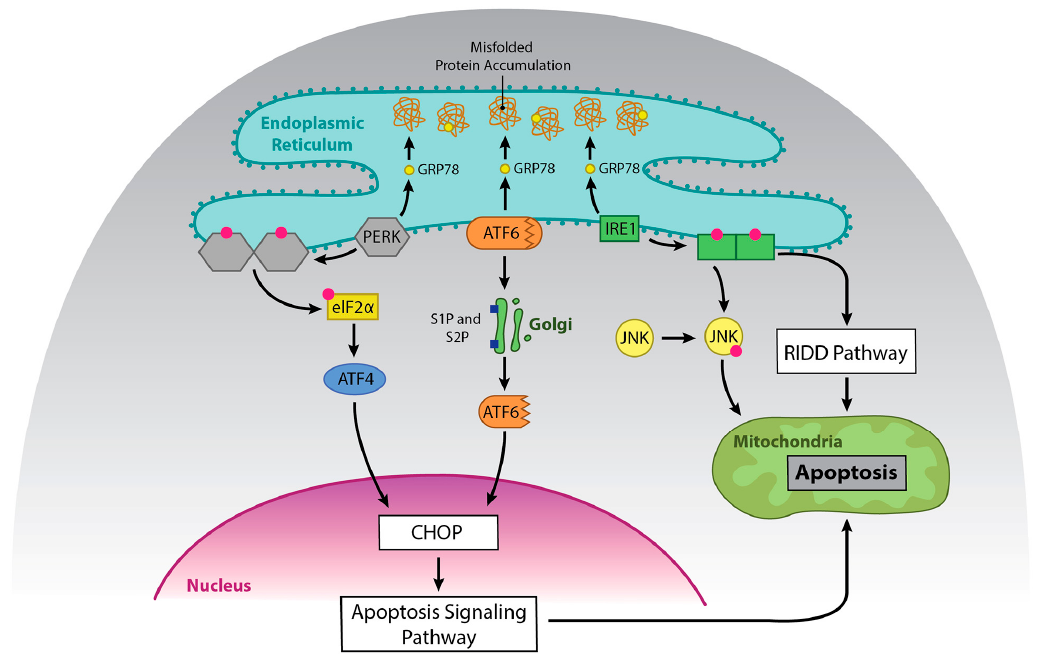
Figure 2. The role of UPR in cell death upon prolonged ER stress. Prolonged activation of UPR can promote apoptosis. Dimerization and phosphorylation of PERK promotes ATF4, which activates CHOP and subsequently apoptosis. ATF6 can also promote upregulation of CHOP. IRE1 α can promote apoptosis via activation of JNK and via degradation of pro-survival RNAs by RIDD.